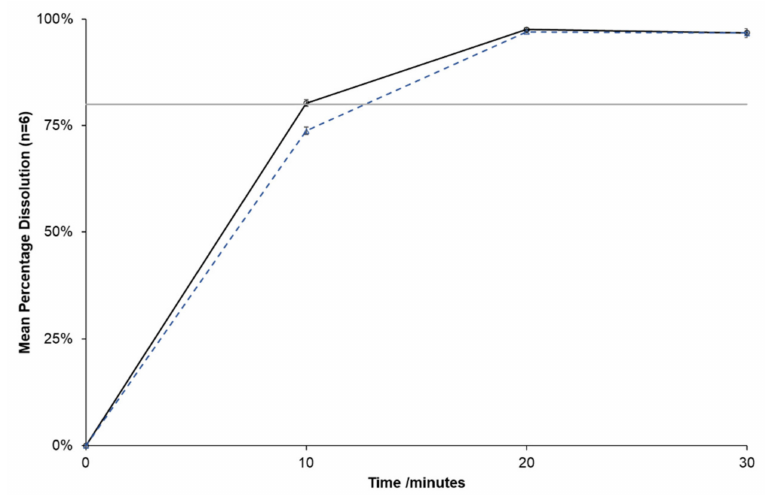
Figure 1. Dissolution profiles of Mizart ® tablets at day 0 (black) and after 28 days storage at 30 ◦ C and 75% RH (blue, dotted). Data shown represent mean ± SEM for (n = 6)